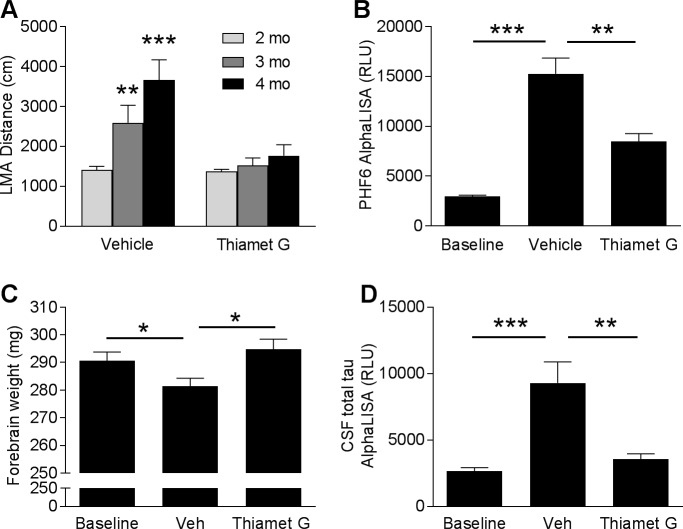
Effects of OGA inhibitor Thiamet G treatment on rTg4510 disease progression.(A) LMA was measured at the baseline (2 months of age) and monthly after the onset of treatment (n = 20–21/group; **p < 0.01, ***p < 0.001, Two-way ANOVA followed by Bonferroni's test compared to baseline groups at 2 months of age). (B–D) Thiamet G significantly reduced brain hyperphosphorylated tau levels detected by PHF6 AlphaLISA (B), prevented brain atrophy (C), and reduced CSF total tau levels (D) in rTg4510 mice (n = 21/group; *p < 0.05, **p < 0.01, ***p < 0.001, one-way ANOVA followed by Dunnett’s test compared to vehicle group).